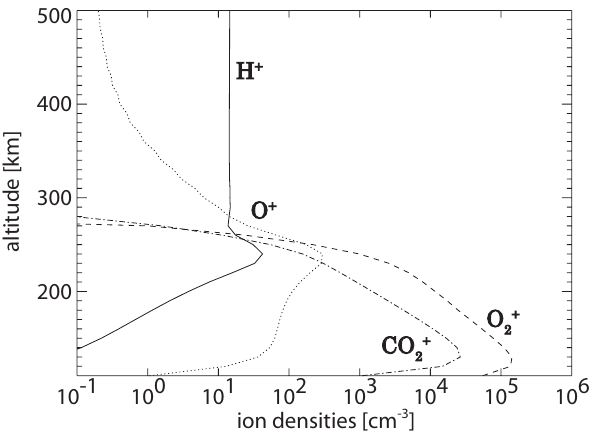
Fig. 4. The altitude profiles of the ion densities at the subsolar